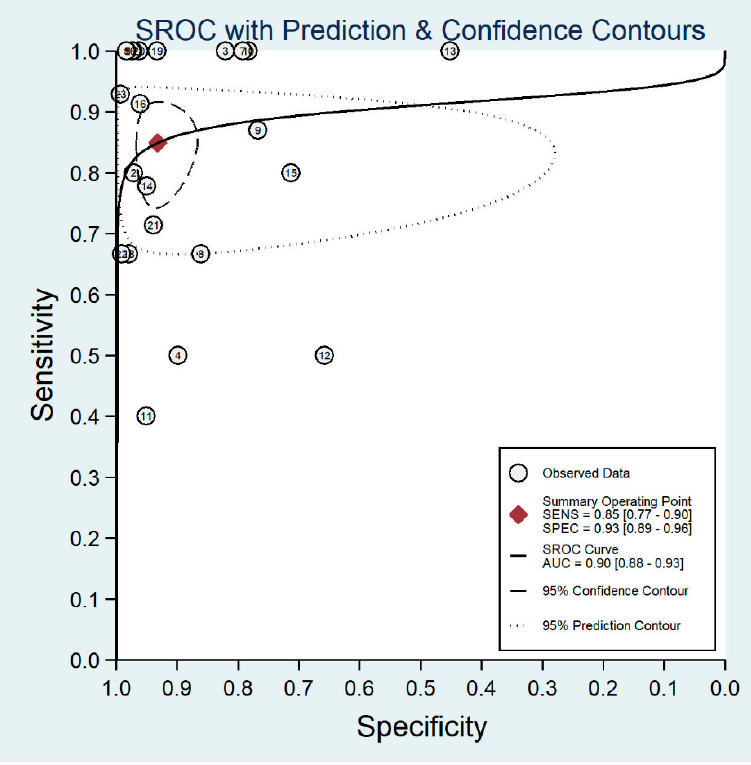
Figure 8. Receiver operating characteristic curve for smartphone-based imaging.